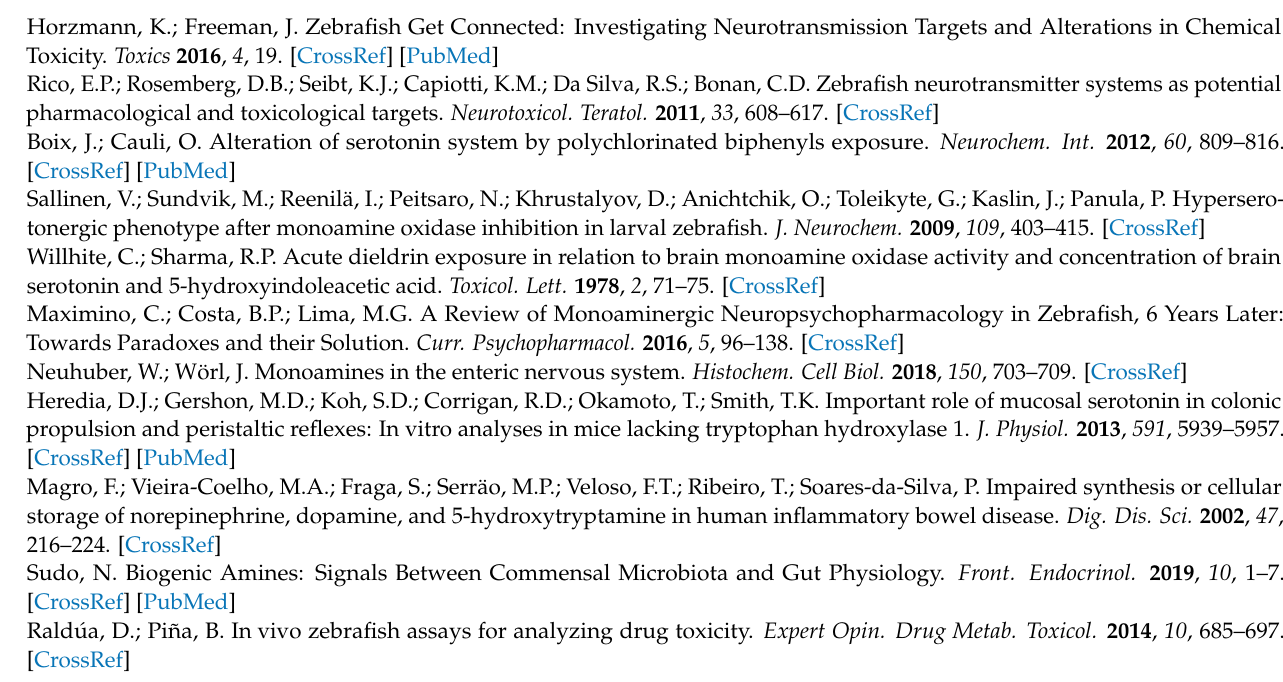
Figure S1: Supplementary Figure S1. Level of the section of the head and trunk in 8 days post- fertilization zebrafish larvae; Figure S2: Levels of ten monoaminergic neurochemicals in the head and trunk of zebrafish larvae (data normalized by larva); Figure S3: Distribution of ten monoaminergic neurochemicals between head and trunk of zebrafish larvae exposed to 5 µ M deprenyl for 24 h (data normalized by larva); Supplementary Table S1: Quality parameters obtained by LC-MS/MS for the 10 monoaminergic neurochemicals; Supplementary Table S2: Protein content in whole body, heads, and trunks of control and deprenyl-treated 8 days post-fertilization zebrafish larvae; Supplementary Dataset 1: Data on neurochemicals levels in the head, trunk, and whole body of larvae control and those exposed to 5 µ M deprenyl for 24 h, normalized by protein content and